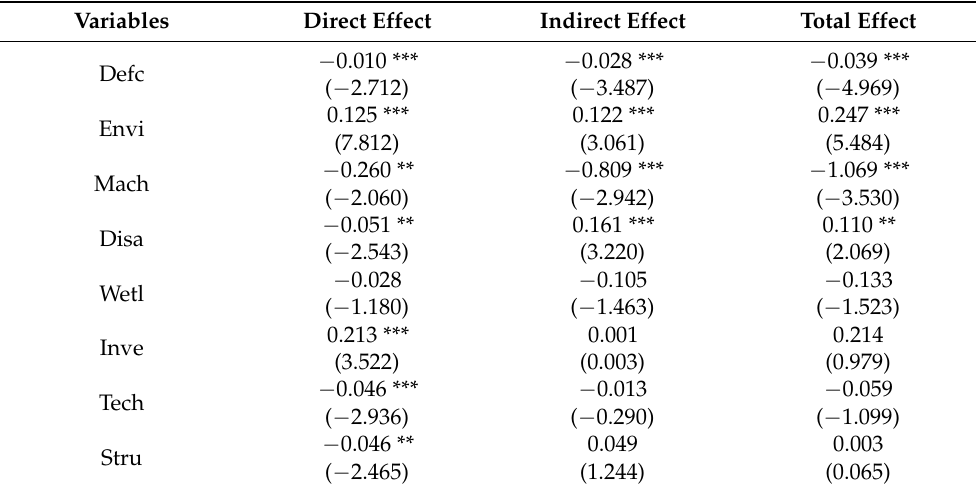
Table 8. Decomposition results of spatial spillover